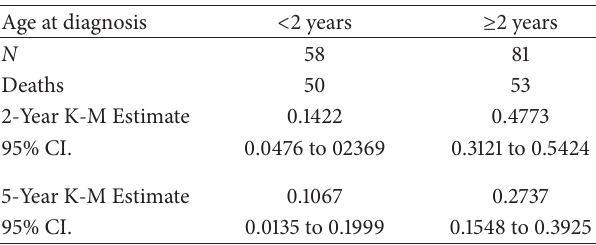
Table 1: Kaplan-Meier survival estimates showing the proportion of patients surviving at given time from diagnosis.